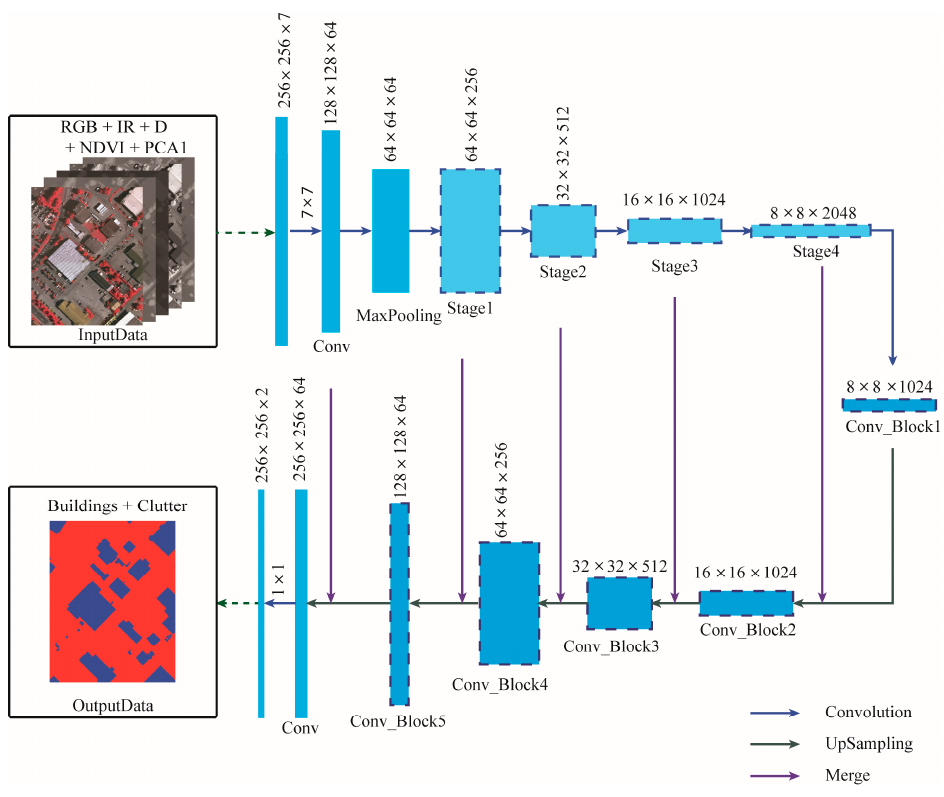
Figure 2. The architecture of the Res-U-Net used in this work. Each box represents the feature map and the x-y-size of the map is provided at the lower right edge of the box. The arrows denote the different operations which are explained at the lower right of the figure.